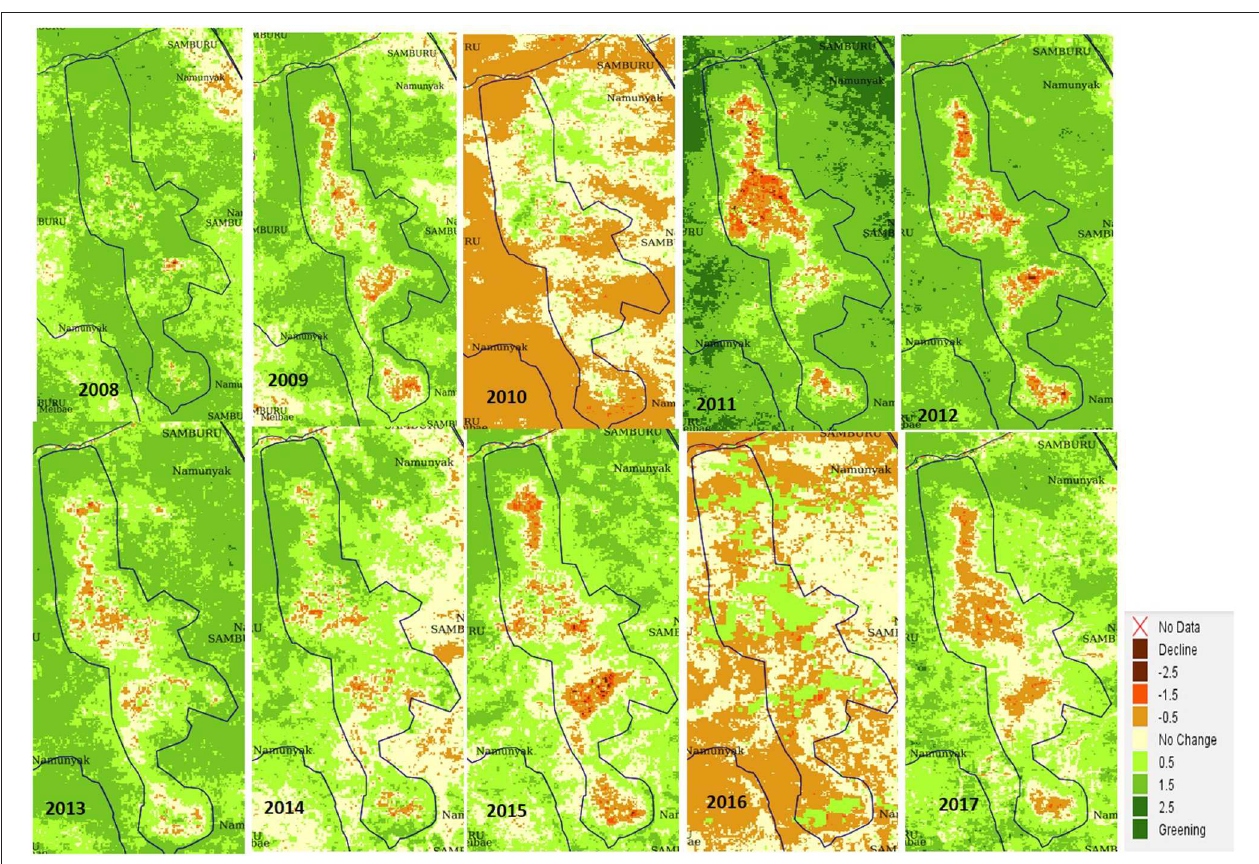
FIGURE 7 | Implication of prolonged drought events on Mathews Range Forest Reserve.